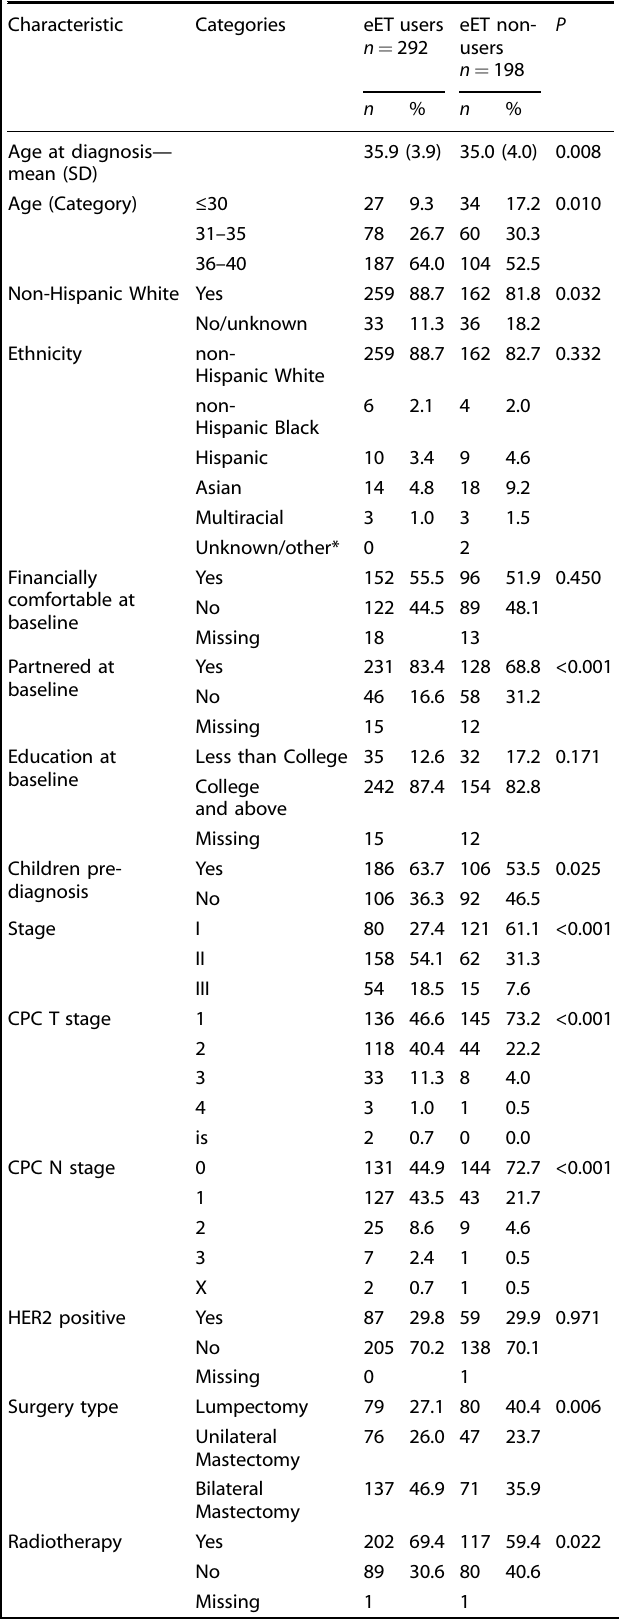
Table 1. Comparison of extended endocrine therapy users and non-